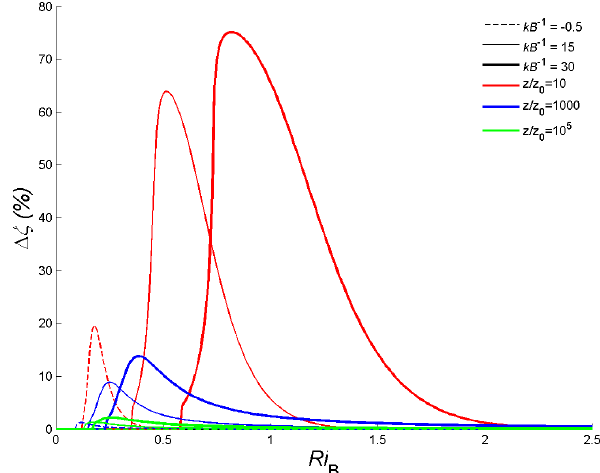
Fig. 2. The relationship between log (z/z 0 ) and ζ from the precise results of CB05. Black line indicates the cubic fit of curve kB − 1 = 30 and Ri B = 0 . 5 with least square method.